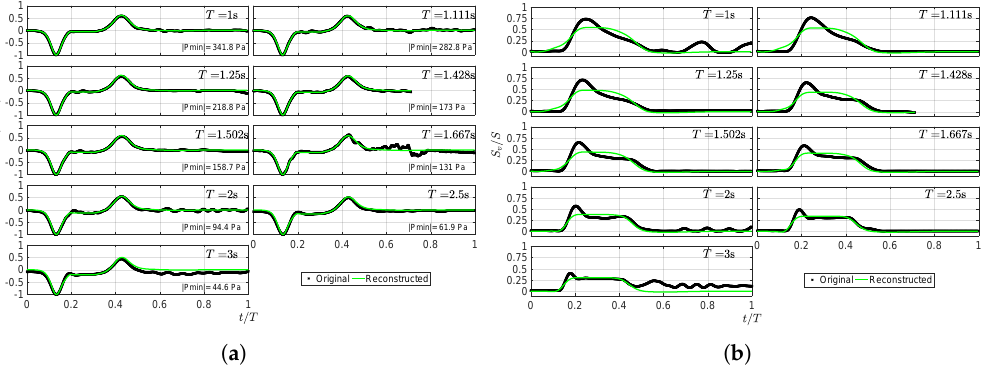
Figure 5. Signals reconstructed using the ARX model for E = 2.15 MPa during the training process. In ( a ), the pressure difference ( ∆ P) and, in ( b ), the normalized opening area ( S v ). The average accuracy obtained for reconstructing the nine periods was R = 96.14% and R = 89.35% for ∆ P and S v respectively. The average goodness of fit of the five E (cid:48) s is listed in Table